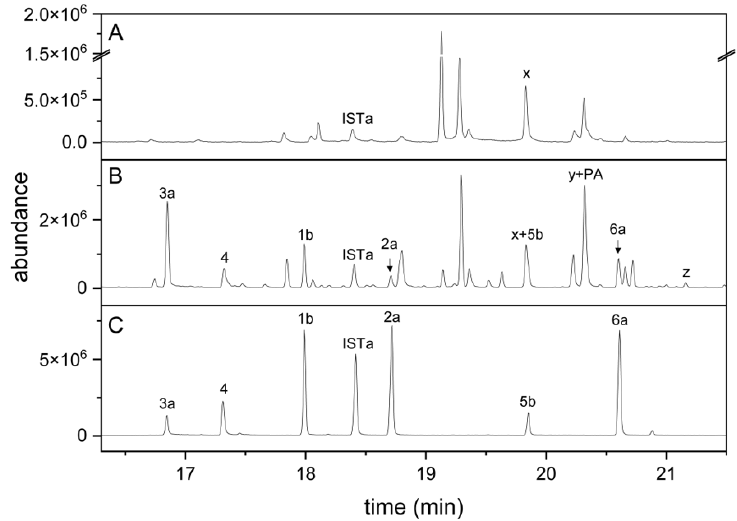
Figure 3. Indole glucosinolate breakdown products in root homogenates of A. thaliana cyp79b2 cyp79b3 and Col-0 plants. ( A ) cyp79b2 cyp79b3 ; ( B ) Col-0; ( C ) mixture of synthetic standards. Dichloromethane extracts of root homogenates or the standard mixture were dried, derivatized and analyzed by GC-MS. TIC traces are shown. Numbers refer to compounds in Table 1 (detected after complete silylation), and IST refers to the I3CN internal standard. Suffix a indicates silylation in one position, and suffix b silylation in two positions. x, unidentified compound. Peak y represents threefold silylated 4OHI3C plus silylated palmitic acid (PA), and peak z represents twofold silylated